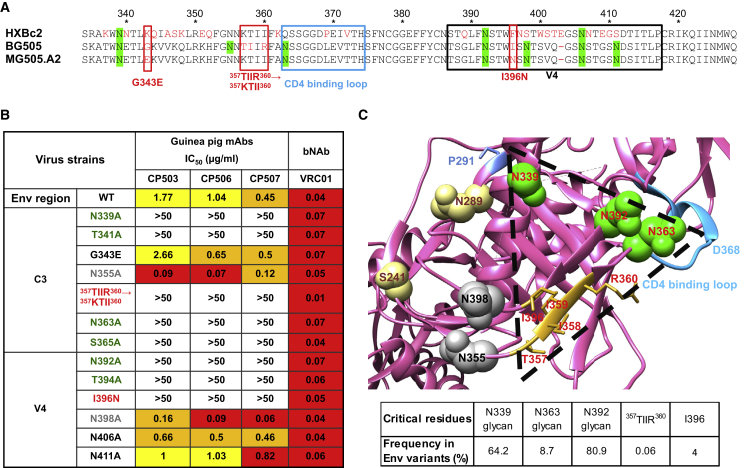
Epitope Mapping of CP506 Lineage mAbs(A) Sequence alignment of gp120s of HXBc2 (resistant to CP506 neutralization), BG505.W6M.C2 (sensitive to CP506 neutralization), and MG505.W0M.A2 (resistant to CP506 neutralization). Residues that differ between BG505.C2 and MG505.A2 on the C3 and V4 region are denoted in red boxes. CD4 binding loop is depicted by the blue box. PNGS are highlighted in green.(B) Neutralization (IC50, μg/mL) of guinea pig NAbs against BG505 T332N Env-pseudotyped viruses bearing mutations in the C3 and V4 region. Critical and non-critical glycans are listed in green and gray, respectively. Other residues critical to neutralization sensitivity are listed in red. Data were generated in duplication, with the mean of IC50 shown.(C) CP506 footprint determined by mutagenesis analysis in (B). (Top) Mutated residues for CP506 lineage mAb epitope mapping are shown on the crystal structure of BG505 SOSIP.664 (PDB: 4TVP). Critical and non-critical glycans are labeled in green and gray spheres, respectively. The 357TIIR360 strand and I396 are highlighted in gold. Residues 241 and 289, the centers of the 241/289 glycan hole, are labeled in yellow. The minimal footprint of CP506 lineage mAbs mapped here is outlined by a triangle. (Bottom) The frequency of CP506 binding critical residues in Env sequences retrieved from the Los Alamos National Laboratory database (https://www.lanl.gov/).